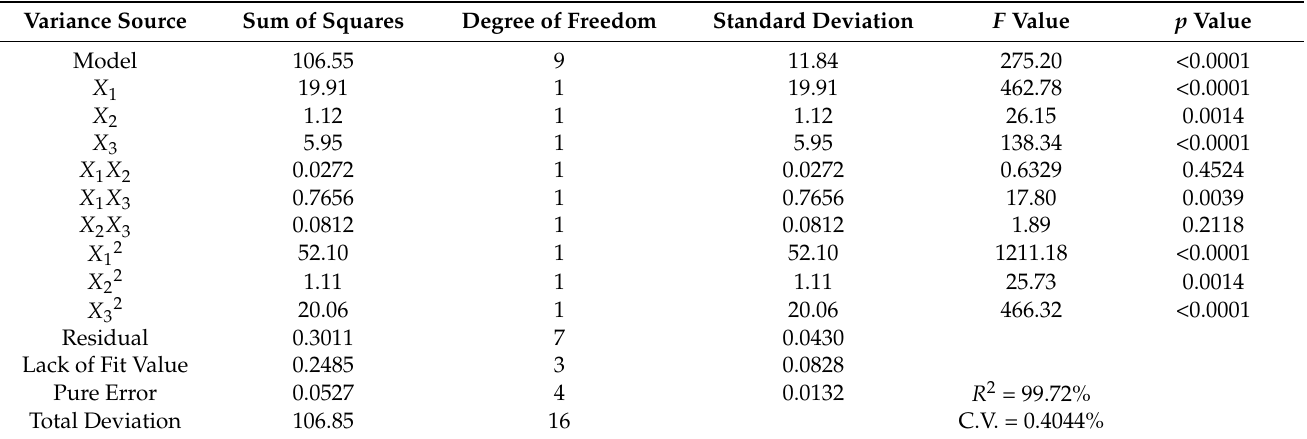
Table 18. Variance analysis of response surface regression